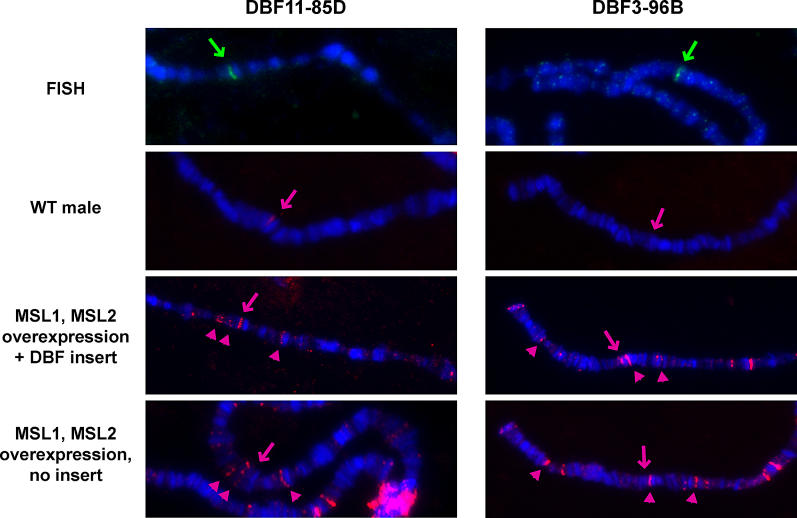
Increasing the Levels of the DCC Increases Recruitment to Low-Affinity Binding FragmentsPolytene chromosomes showing FISH signals (top panels, green) and anti-MSL1 staining (red) in the genetic backgrounds indicated. Arrows indicate the position of the inserts and arrowheads indicate autosomal sites of DCC binding in the MSL1 and MSL2 over-expression background. Recruitment of the DCC to the DBF11-85D insert is enhanced when the levels of DCC are increased by over-expression of MSL1 and MSL2 compared to wild-type males. The DBF3-96B insert does not recruit the DCC in wild-type males, but recruitment can be seen when MSL1 and MSL2 are over-expressed.